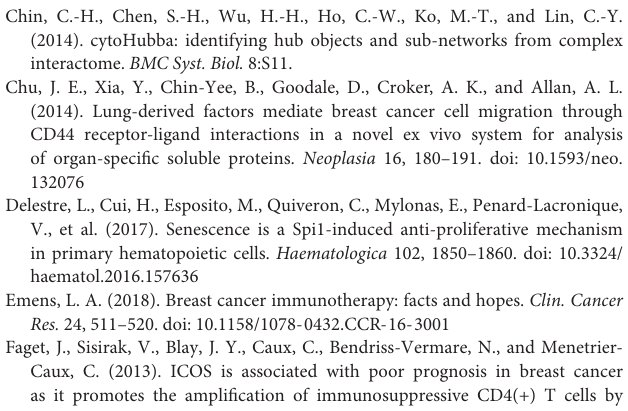
Supplementary Figure 1 | The PPI network for all DEGs. Supplementary Figure 2 | The three subnetworks of PPI according to (A) degree, (B) betweenness, and (C) closeness. Supplementary Figure 3 | Venn diagram of three subnetworks. Supplementary Figure 4 | CD34, IL6, SPI1, and SELL expression in different cancer types. (A–D) The expression levels of CD34, IL6, SPI1, and SELL in TCGA are shown. The meaning of the statistical difference is as follows: ns represents not significant ( p > 0.05), ∗ represents p ≤ 0.05, ∗∗ represents p ≤ 0.01, and ∗∗∗ represents p ≤ 0.001. Supplementary Figure 5 | The relationship between clinical features and pDC abudance. (A) Tumor stage. (B) Age. Supplementary Table 1 | Demographic characteristics of two